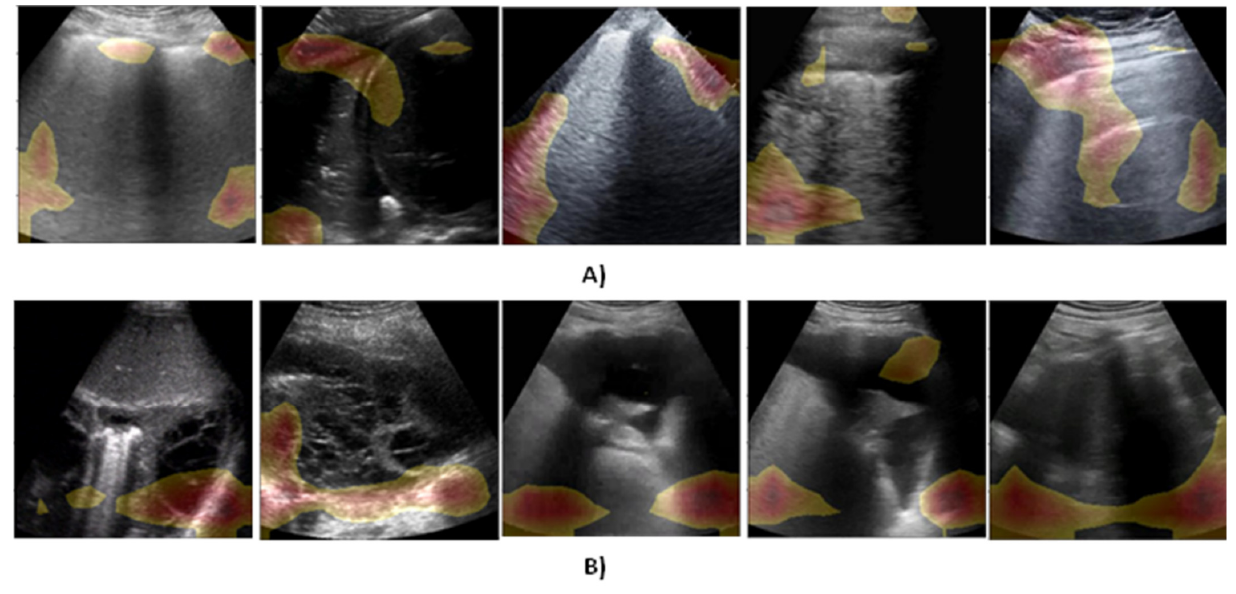
Figure 3. Illustration of visual explanation maps generated by Grad-CAM++ for some of the samples of lung ultrasound frame images after visualization. ( A ) COVID-19-infected lung, ( B ) Pneumonia- infected lung.